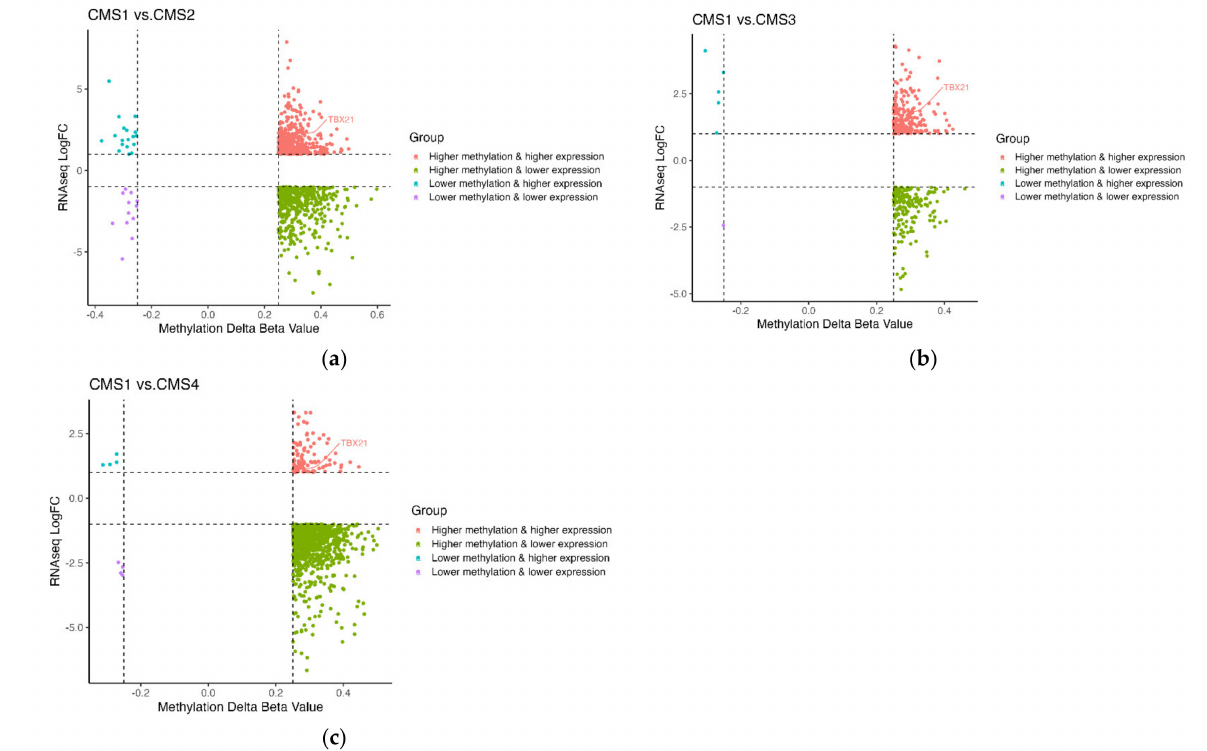
Figure 3. The distribution of crosstalk genes. Among the identified crosstalk genes for each compari- son, most crosstalk genes were enriched in quadrants 2 and 3. TBX21 was the only gene differentially expressed and differentially methylated across three comparisons. The x -axis is the delta beta value of methylation, the y -axis is the RNAseq LogFC. ( a ) Distribution of crosstalk genes from CMS2 vs. CMS1 DEG and DMG analysis. ( b ) Distribution of crosstalk genes from CMS3 vs. CMS1 DEG and DMG analysis. ( c ) Distribution of crosstalk genes from CMS4 vs. CMS1 DEG and DMG